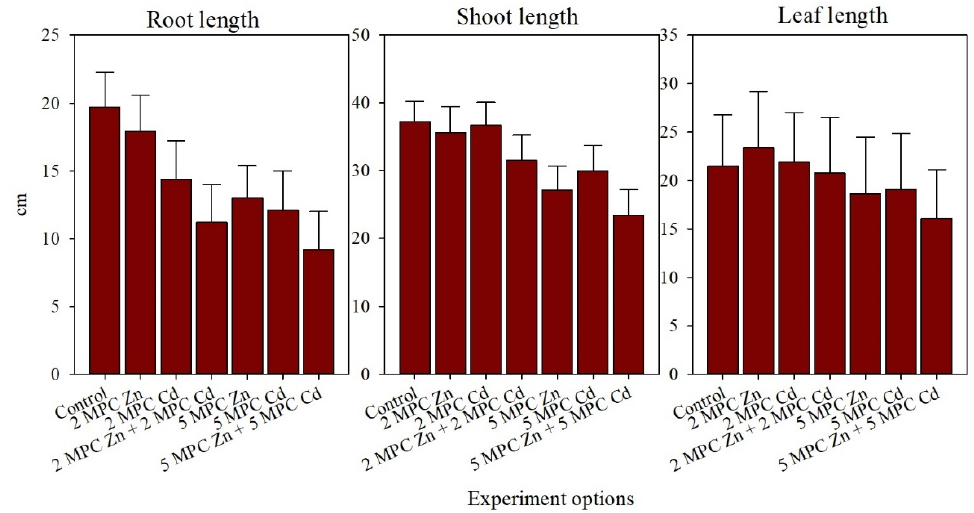
Figure 2. Effects on morphological characteristics of H. vulgare in different treatments of the model experiment,